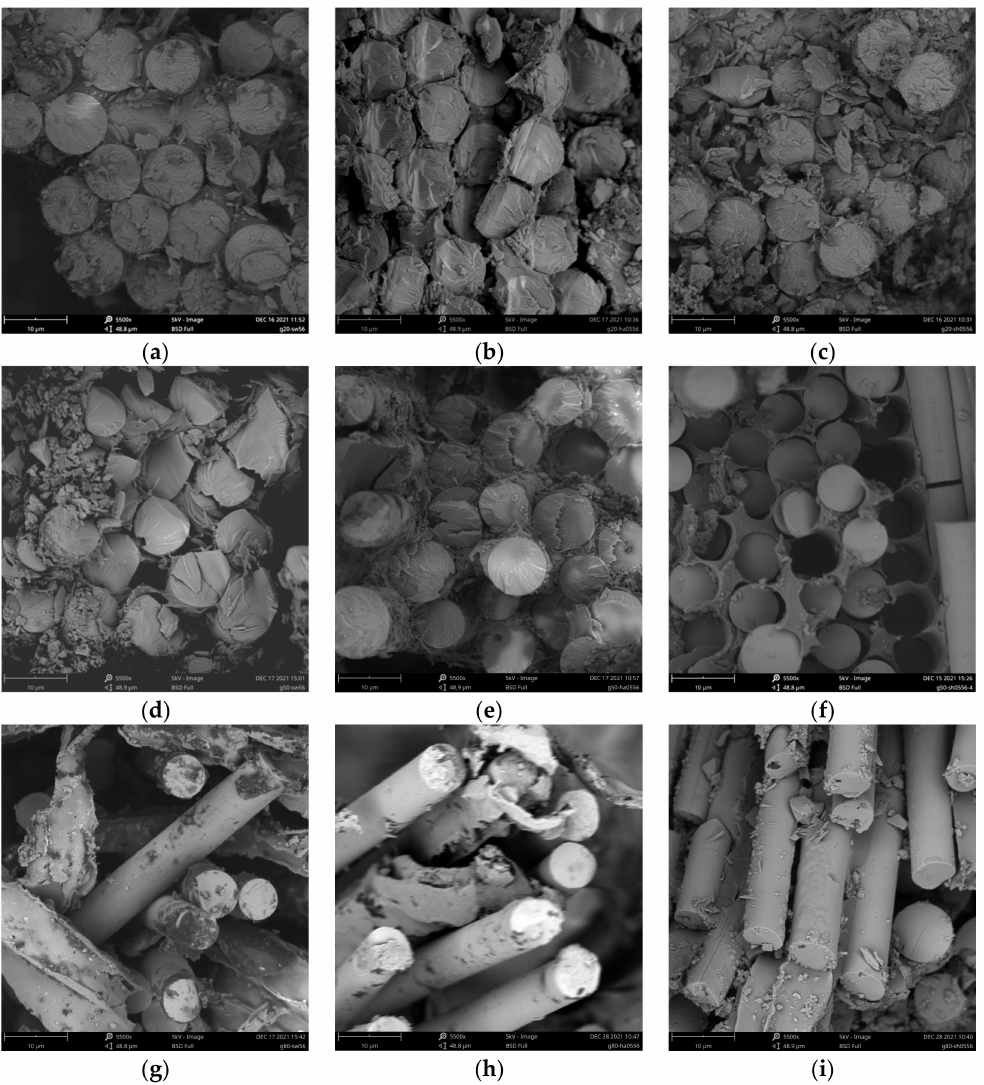
Figure 12. SEM images of fractured sections of specimens. ( a ) SW-20-56, ( b ) 05HA-20-56, ( c )